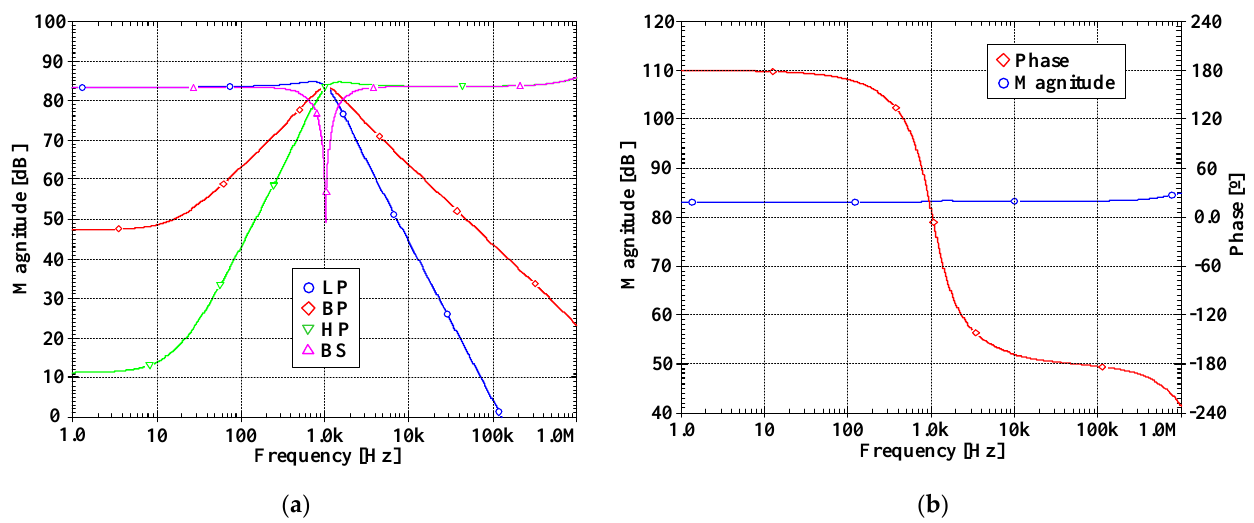
Figure 10. The simulated frequency responses of the TIM filter: ( a ) LP, BP, HP, BS filters; ( b ) AP filter.